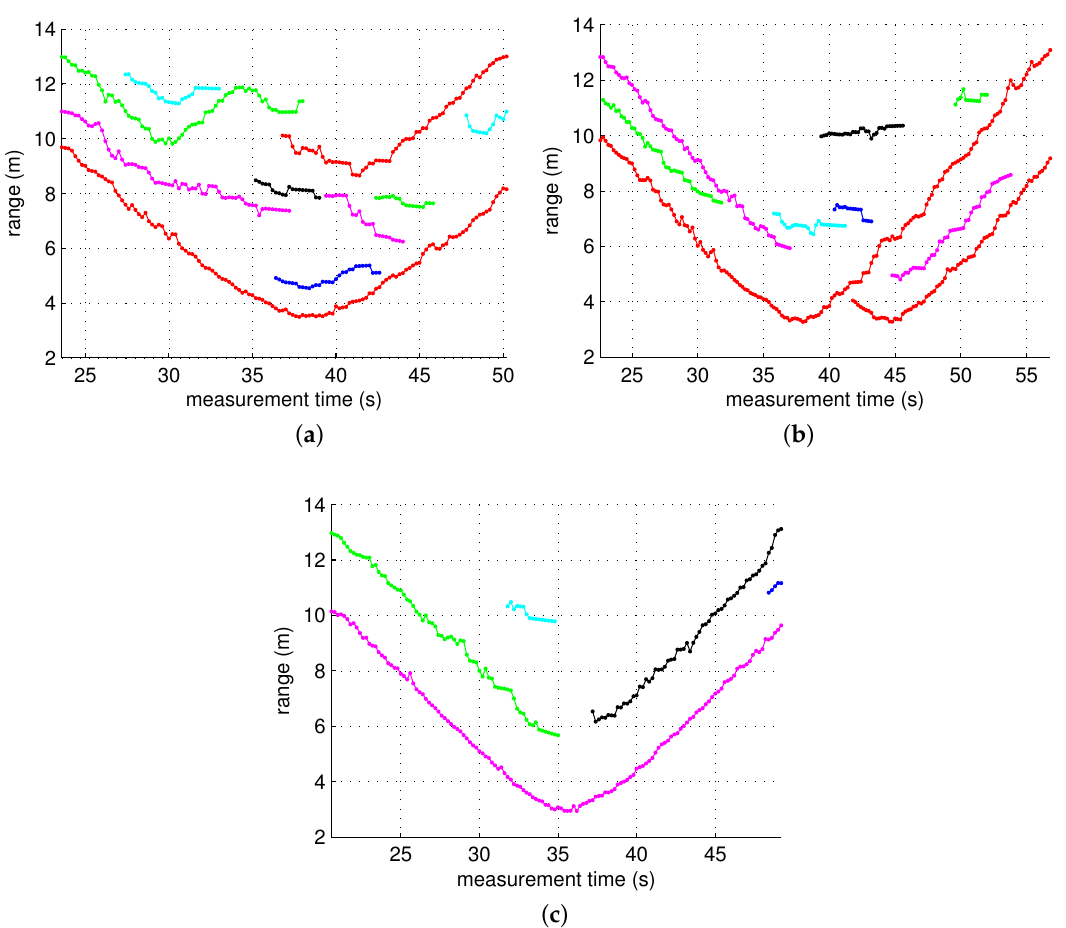
Figure 11. Tracking results for each scenario with ghost rejection. Separate tracks are indicated by different colors. ( a ) Scenario 1; ( b ) Scenario 2; and ( c ) Scenario